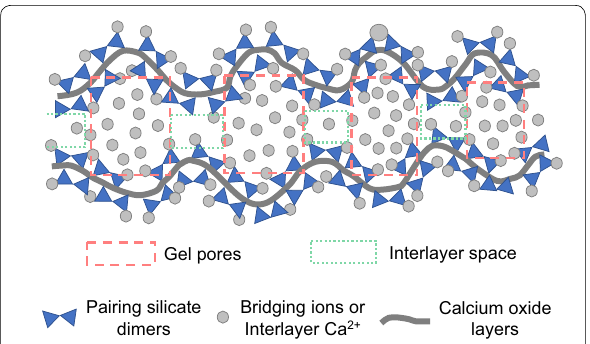
Fig. 2 Range of pore sizes seen in different measurement techniques, adapted from Muller